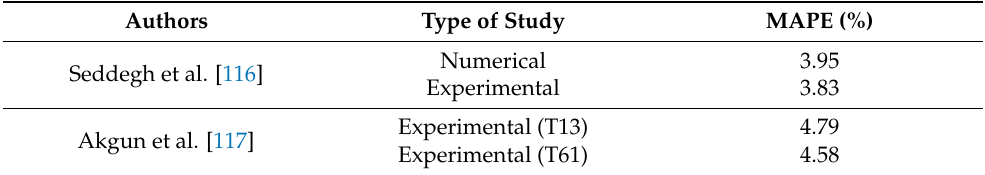
Table 4. Percentage deviation of the present results in comparison with previous studies. Authors Type of Study MAPE